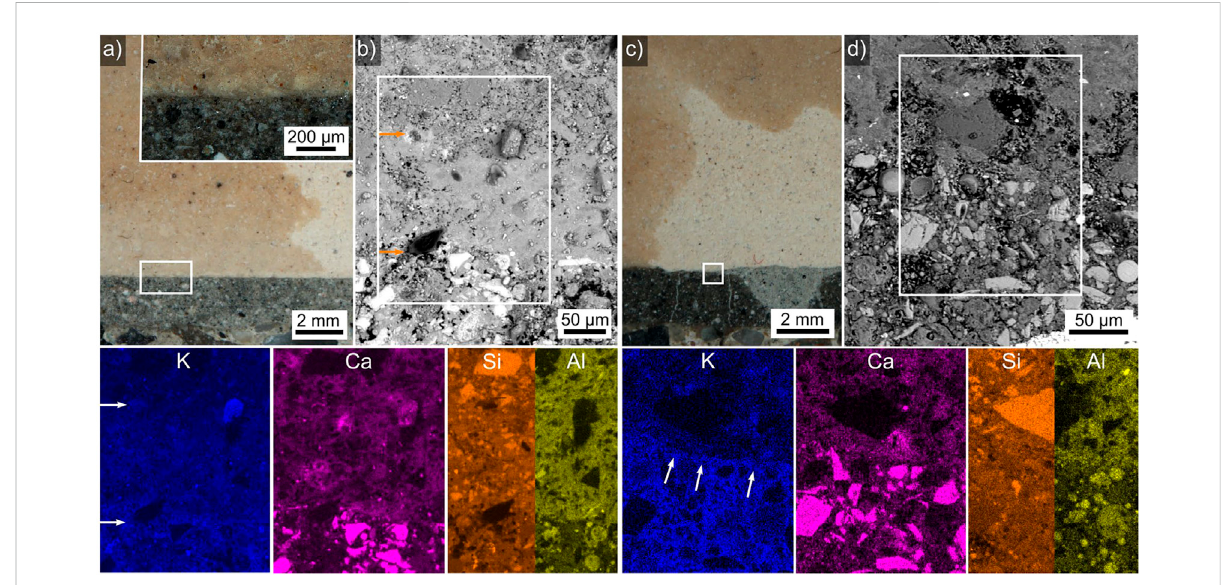
FIGURE 4 (A) An optical micrograph of a ceramic tile (top) in contact to adhesive 4 (bottom), the framed area is presented in greater detail in the inset. (B) SEM micrograph of this interface, EDXS element maps of the framed area are presented below, the orange arrows highlight transitions from the adhesive(bottom)tothebrightceramic(middle)andthedarkceramic(top). (C) Anopticalmicrographofaceramictile(top)incontacttoadhesive12 (bottom), the framed area is presented in greater detail in (D) an SEM micrograph of this interface. Selected EDXS element maps of the framed area are presented below where the white arrows highlight the adhesive/ceramic